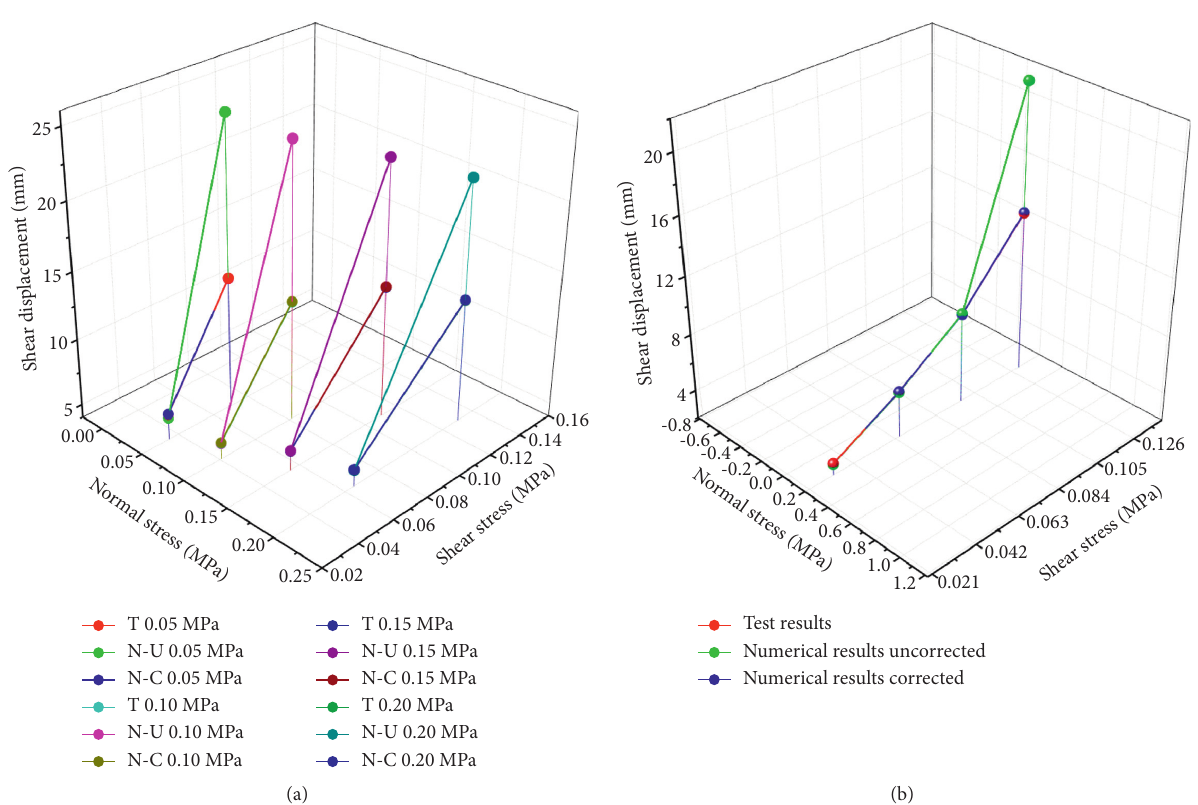
Figure 4: Comparison of test value, uncorrected positive value, and modified positive value. (a) The shear displacement comparison of the shear displacement under different normal stresses (Tis shorthand for test results, N-U is shorthand for numerical results uncorrected, and N-C is shorthand for numerical results corrected). (b) The shear displacement comparison under the same normal stress σ n � 0 . 2MPa.